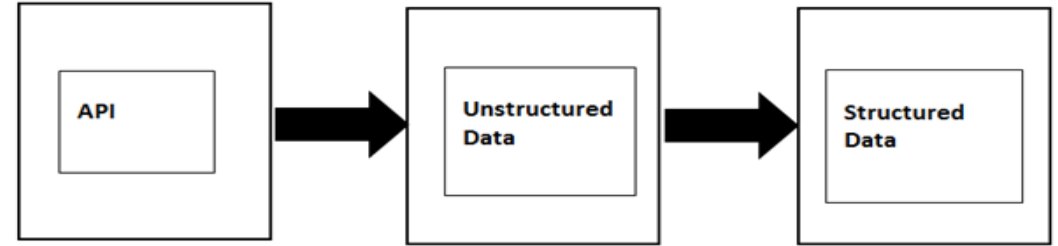
Figure 3. The Workflow developed by using API for the mining of Data